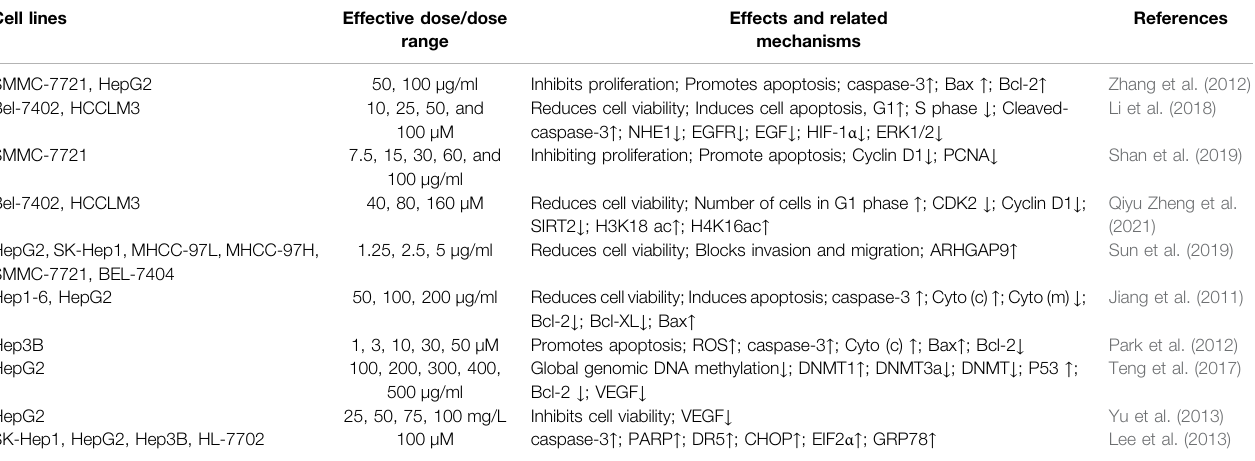
TABLE 7 | In vitro effects of ginsenoside Rg3 on liver cancer cells and the underlying mechanisms. Cell